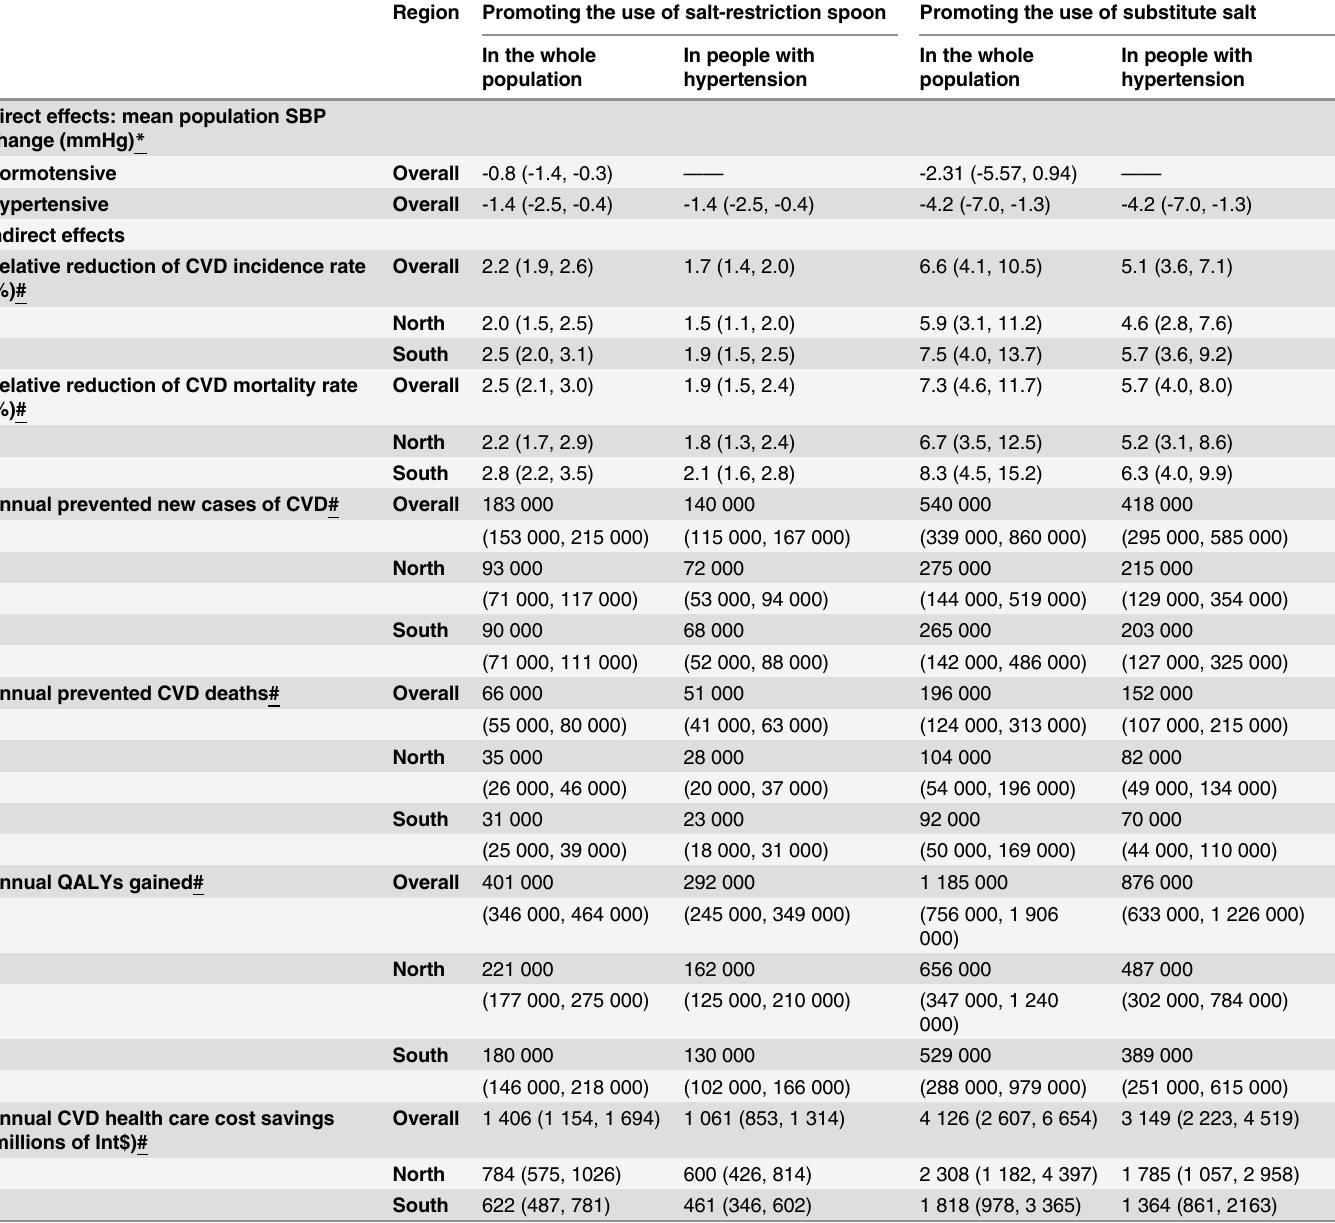
Table 4. Simulated SBP reduction and annual cardiovascular disease outcomes (coronary heart disease and stroke combined) after implementing dietary salt intervention strategies in China, 2010 to 2019, according to the CVD Policy Model-China.